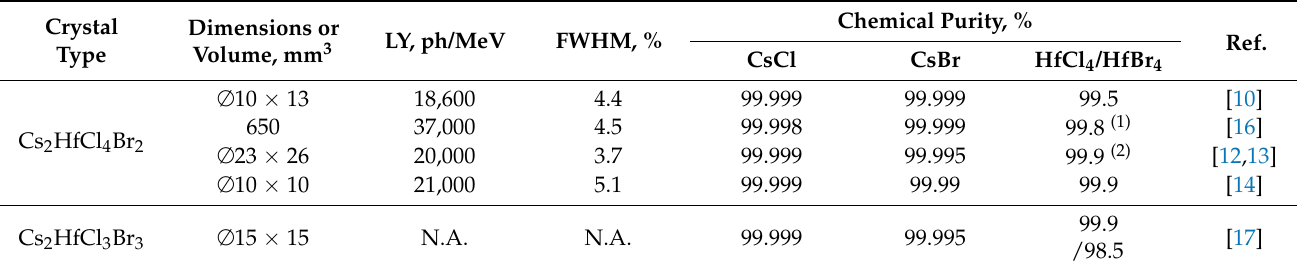
Table 2. List of recently produced Cs 2 HfCl 4 Br 2 and Cs 2 HfCl 4 Br 3 crystals by different groups, crystal dimensions (or volume) used for their characterization, the relative light yield (LY) and energy resolution (FWHM) measured under irradiation by 662 keV gamma line of 137 Cs source, and chemical purity of corresponding raw materials used for crystal growth. N.A. means “not